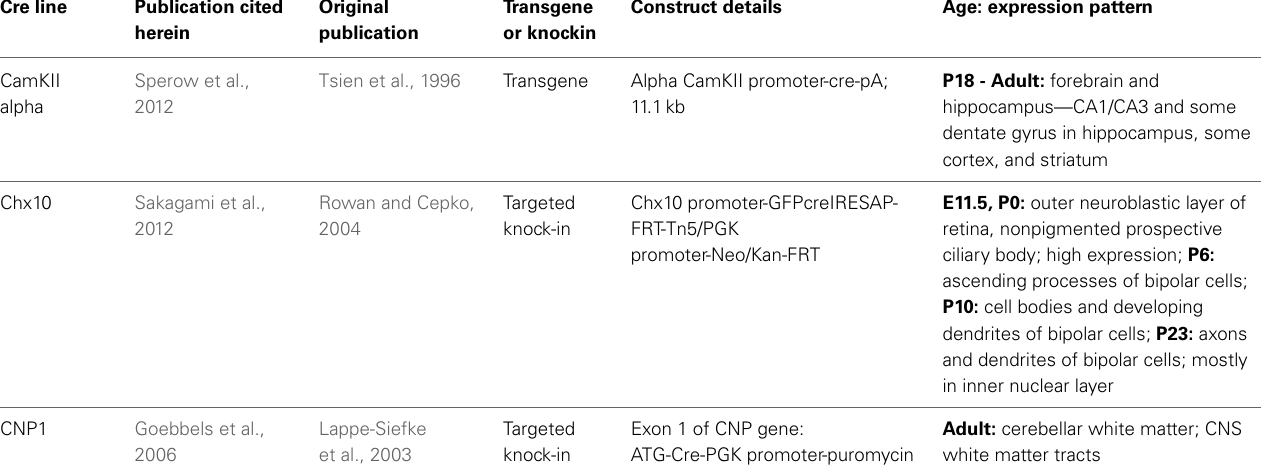
Table 1 | Summary of Cre lines cited in this